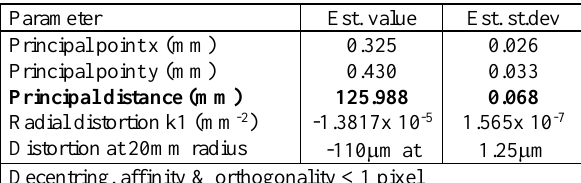
Table 1. Estimated camera calibration parameters for Nikon